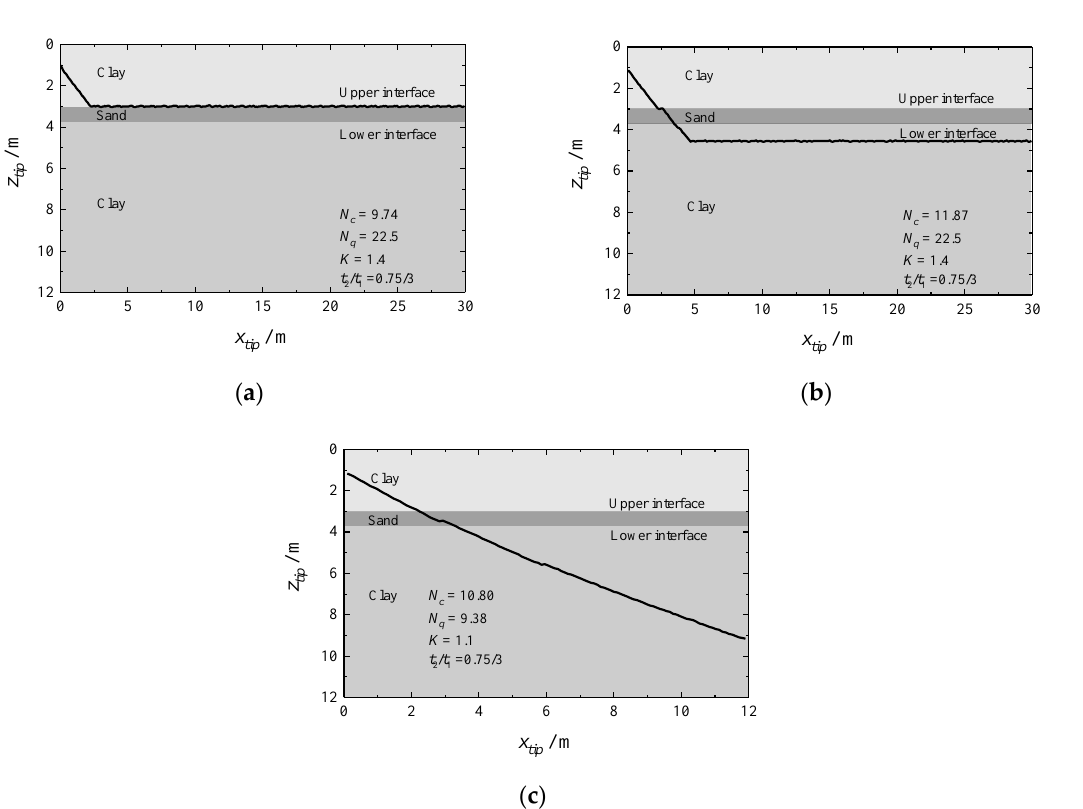
Figure 15. Trajectories in clay-sand-clay layers [17]: ( a ) Case 1; ( b ) Case 2; ( c ) Case 3.